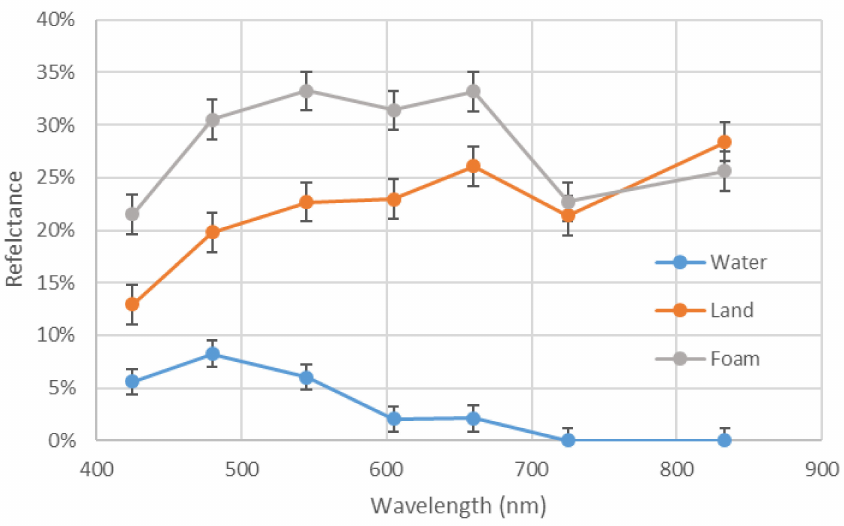
Figure 3. Mean spectral profile of the 3 classes defined in this study: water (blue), land (orange) and foam (grey) and their standard